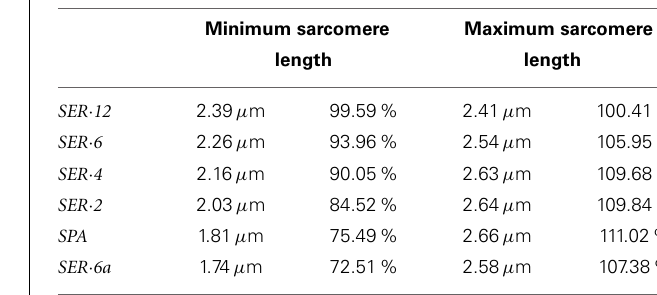
Table 3 | Minimum and maximum sarcomere lengths in fixed-end single twitch contractions absolute and in percent of their length = 2 . 4 μ prior to stimulation, (cid:3) opt S